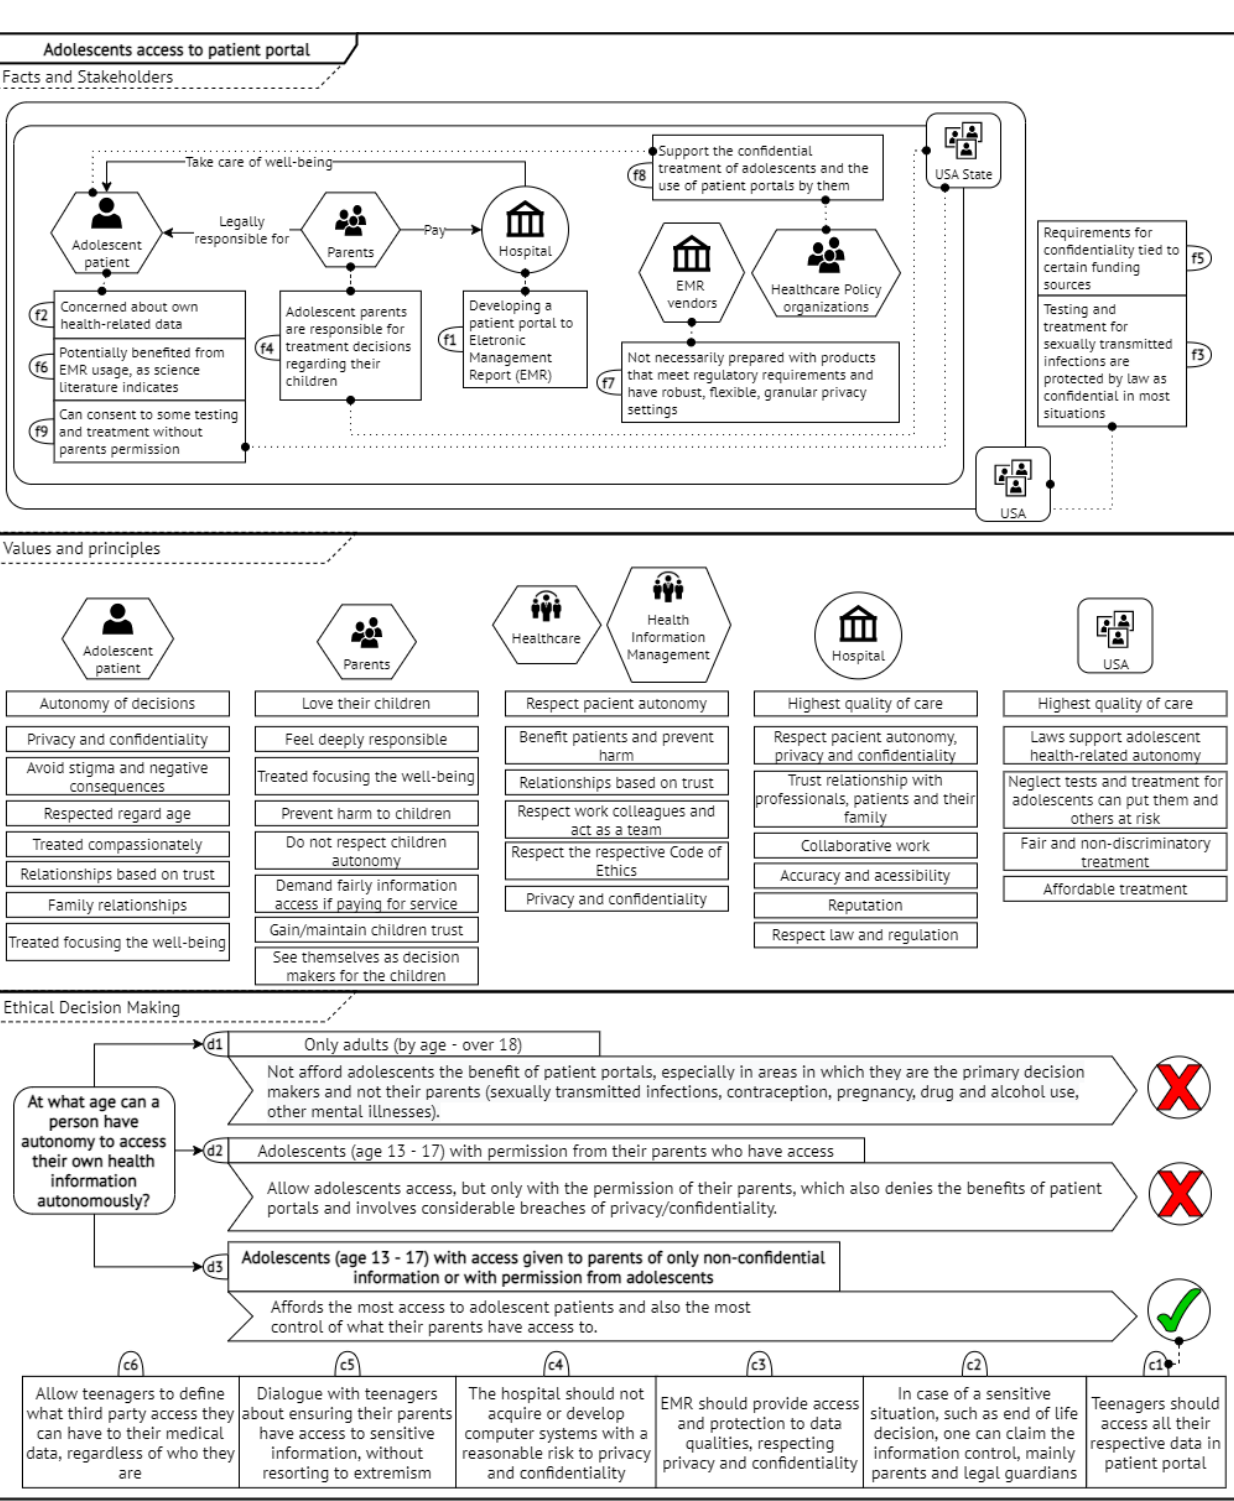
Figure 4. Access by Adolescents to Patient Portals Glover (2017) case